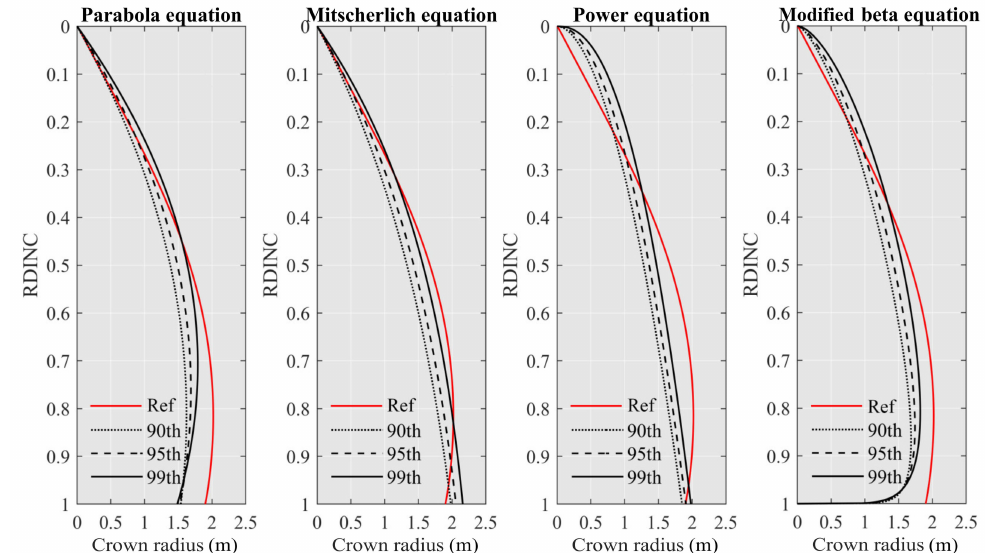
Figure 7. Four types of curves modelled on 90th, 95th, and 99th width percentile points; red curves represent the reference crown